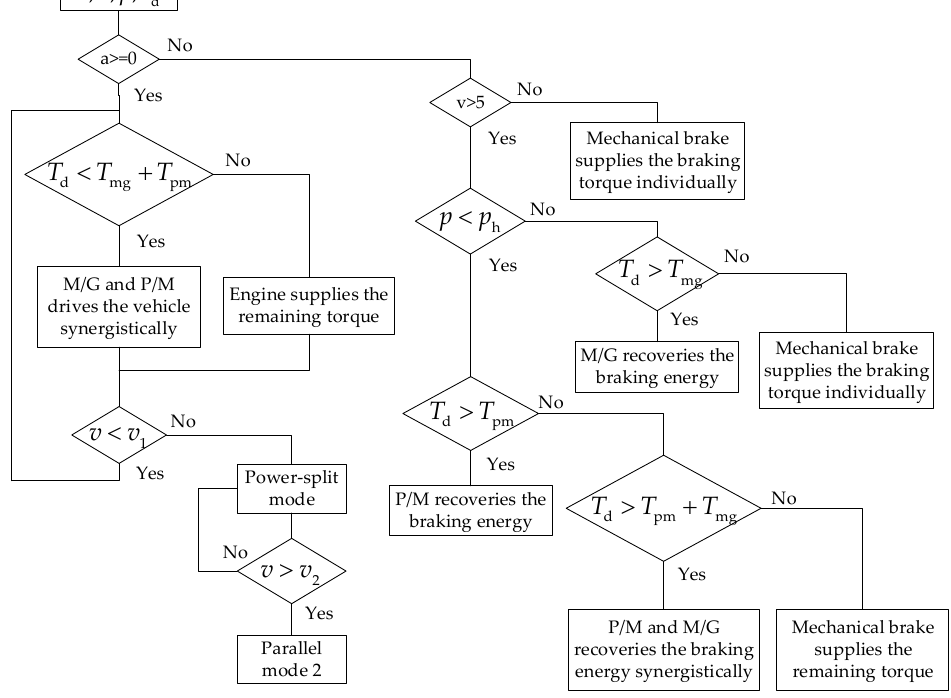
Figure 11. Power management strategy of the HESV.